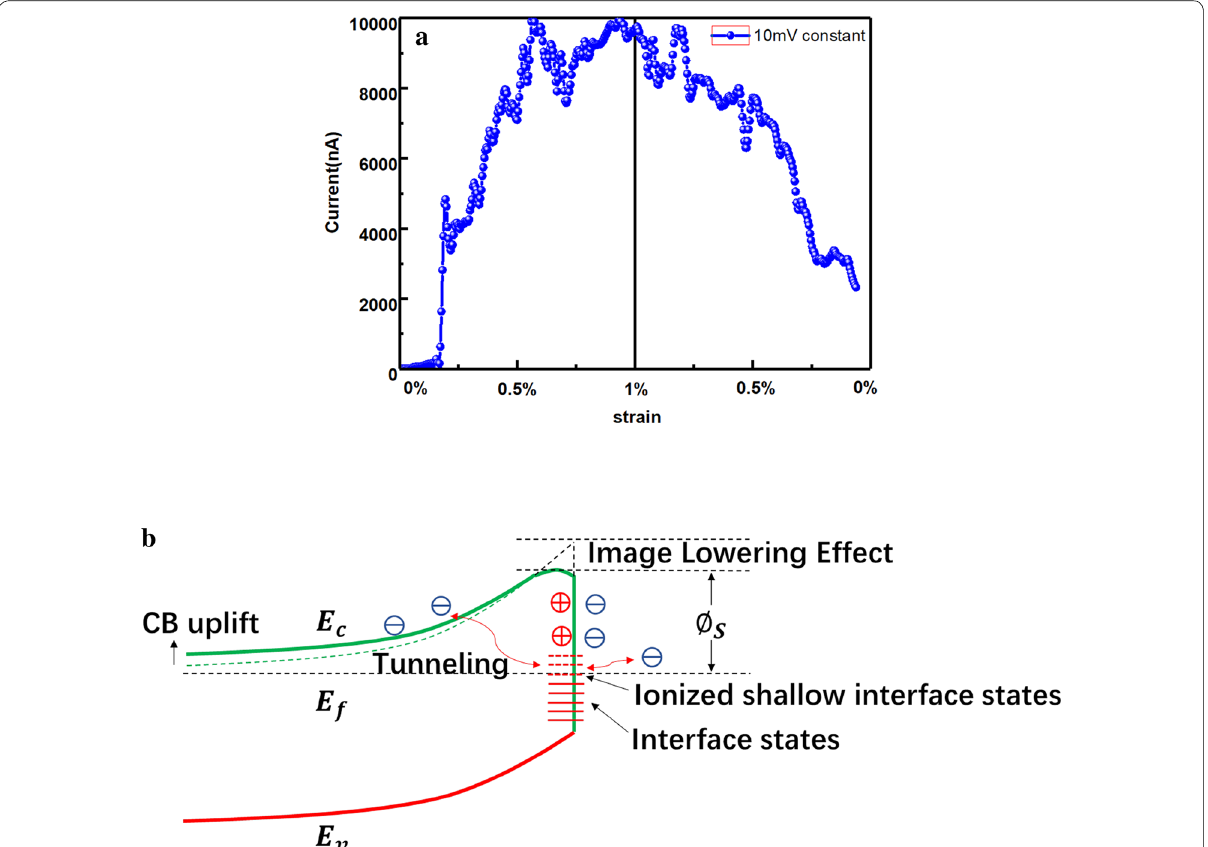
Fig. 6 a Current vs. strain under constant bias of 10 mV on sample 7, b the schematic energy band model with considering the interface